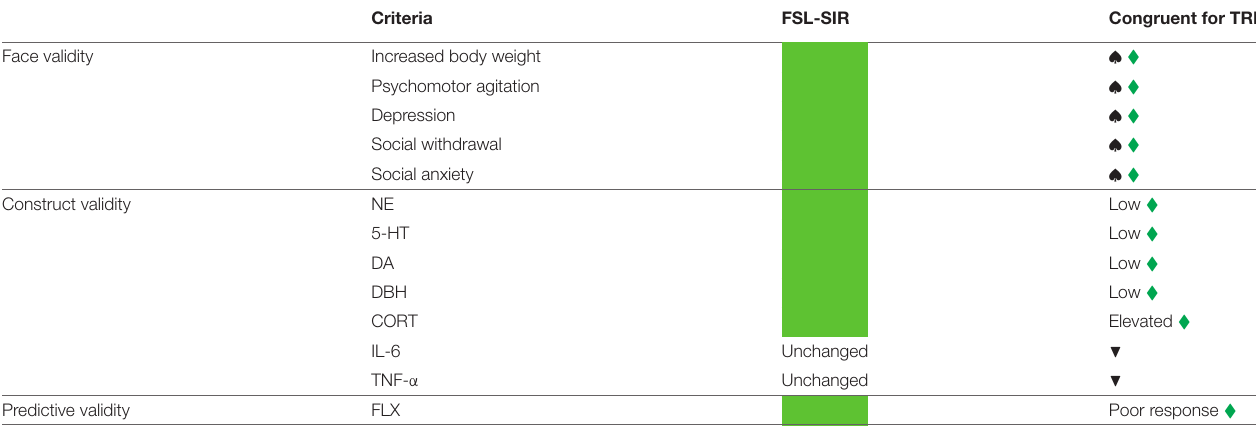
TABLE 2 | Summary of face, construct and predictive validity of the FSL-SIR model with respect to treatment-resistant depression (TRD).